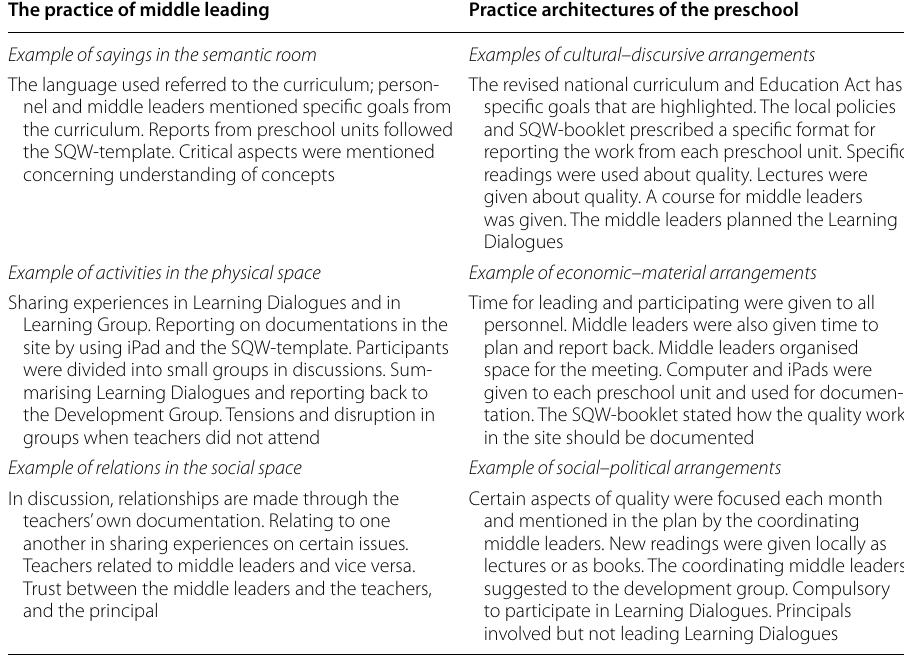
Table 2 How the practice architectures are prefiguring practices around systematic